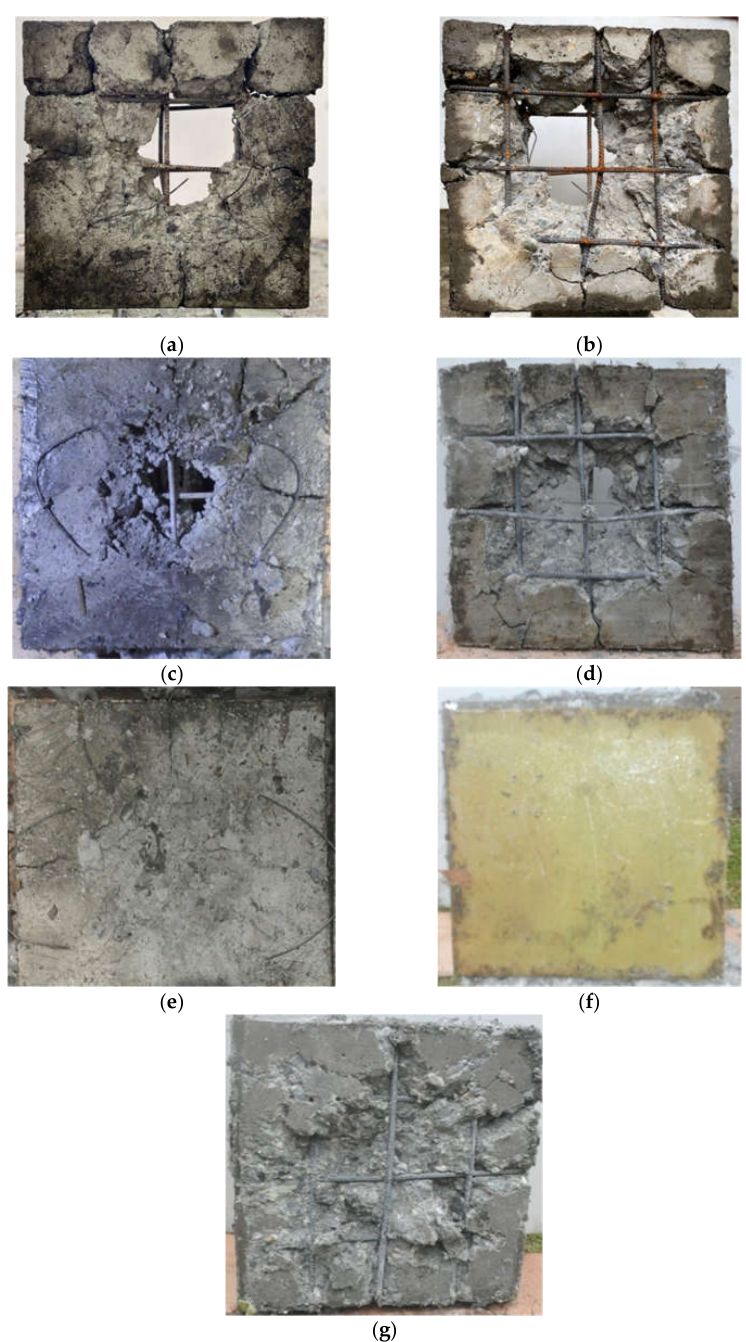
Figure 12. The failure images of SW-B, SW-K10L24, and SW-K10L24-A specimens under shock wave loading: ( a ) front face of SW-B; ( b ) rear face of SW-B; ( c ) front face of SW-K10L24; ( d ) rear face of SW-K10L24; ( e ) front face of SW-K10L24-A; ( f ) rear face of SW-K10L24-A (with KFRP sheet); ( g ) rear face of SW-K10L24-A (KFRP sheet was removed).